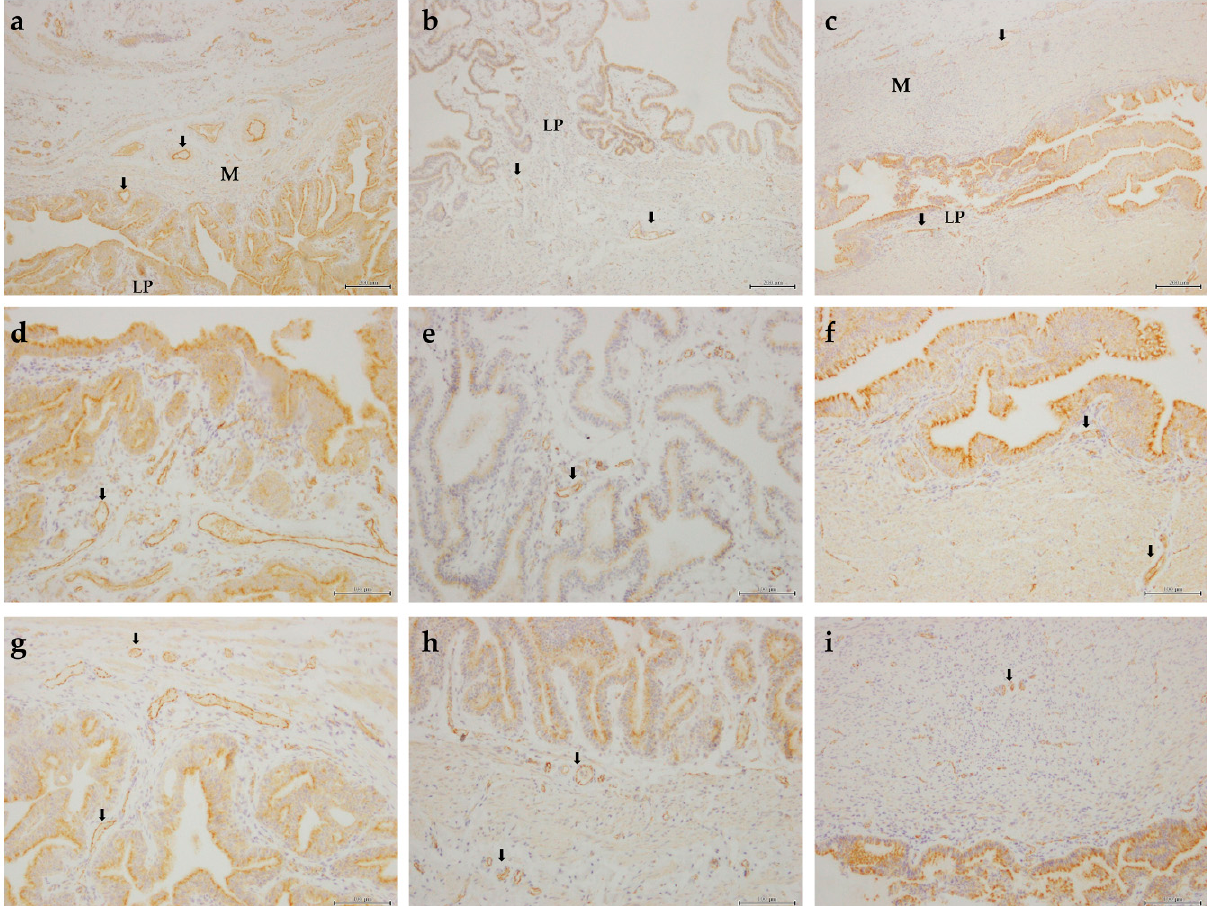
Figure 3. Representative images of vascular structures in the equine oviduct immunostained with anti-CD31 antibody. Infundibulum ( a , d , g ); ampulla ( b , e , h ); isthmus ( c , f , i ). Scale bars of 200 µm ( a – c ) and 100 µm ( d – i ). Black arrows indicate examples of CD31-positive vessels. M—muscularis; LP—lamina propria.